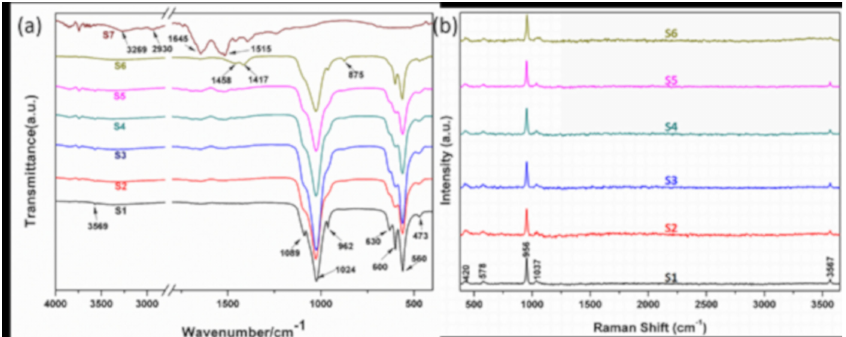
Figure 2. FTIR spectra ( a ) of synthesized HA samples (S1–S5), HA derived from grass carp scales and partially hydrolyzed keratin (S7) and Raman spectra ( b ) of synthesized HA samples (S1–S5) and HA derived from grass carp